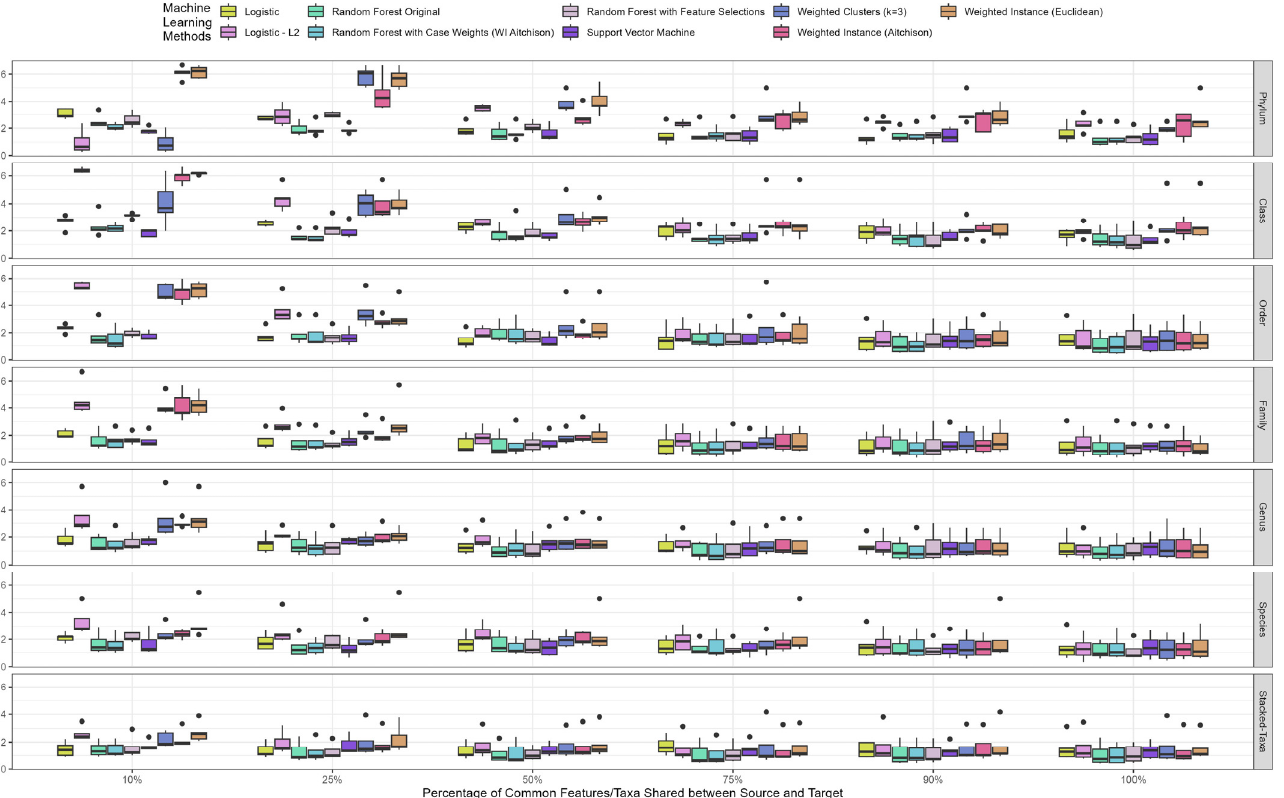
Figure 3. F 1 score interquartile ranges for the percentage of common features/taxa shared between source and target across taxonomic levels and machine learning methods. The x-axis represents nine representative machine learning methods, and the y-axis represents the interquartile range calculated from 100 iterations of our random sampling scheme, and the solid black dot represents the outliers. The plot illustrated the results from colorectal cancer datasets.